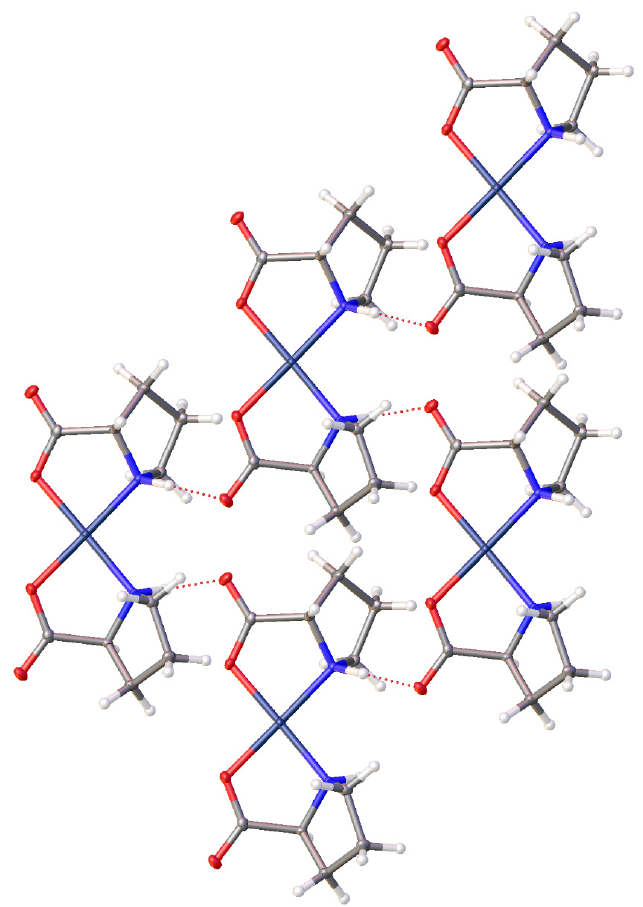
Figure 4. Crystal packing diagram for complex 1 viewed along [001] showing the intermolecular hydrogen bonding motif.